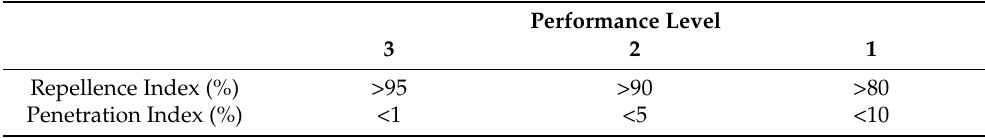
Table 1. Repellence and penetration indexes, in percentage, and respective performance level, according to ISO